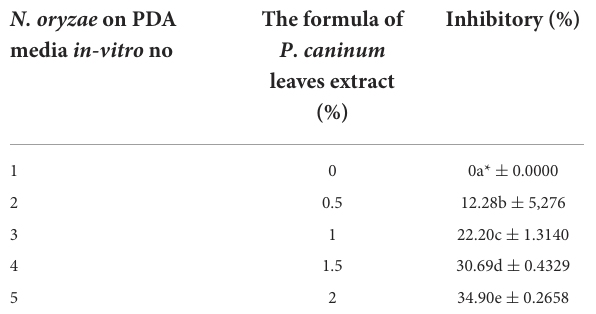
TABLE 1 The inhibitory P. caninum leaf extract against the diameter of the fungal colony. N. oryzae on